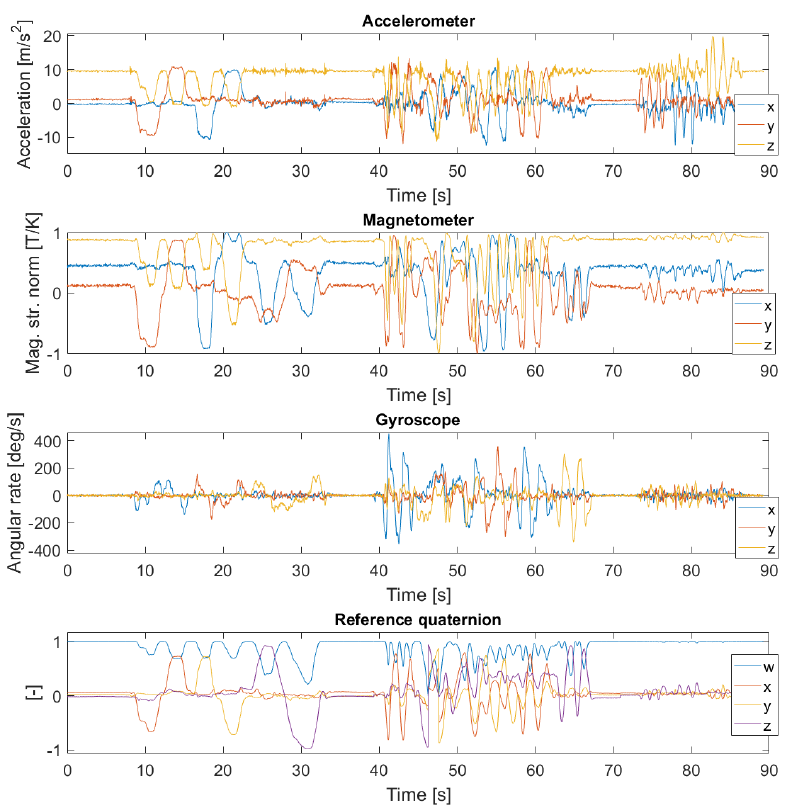
Figure 4. The measured data from all three experiments. The first three rows display data from the MARG sensor: all three axes, x , y , z , of the accelerometer, magnetometer, and gyroscope, respectively. The measured positions of the points on the platform from the VICON system were converted to the reference quaternion that is displayed via its vector components, w , x , y , z (3) in the bottom row. The slow rotations occur between 0–40 s, fast rotations between 40–72 s, and dynamic accelerations after 72